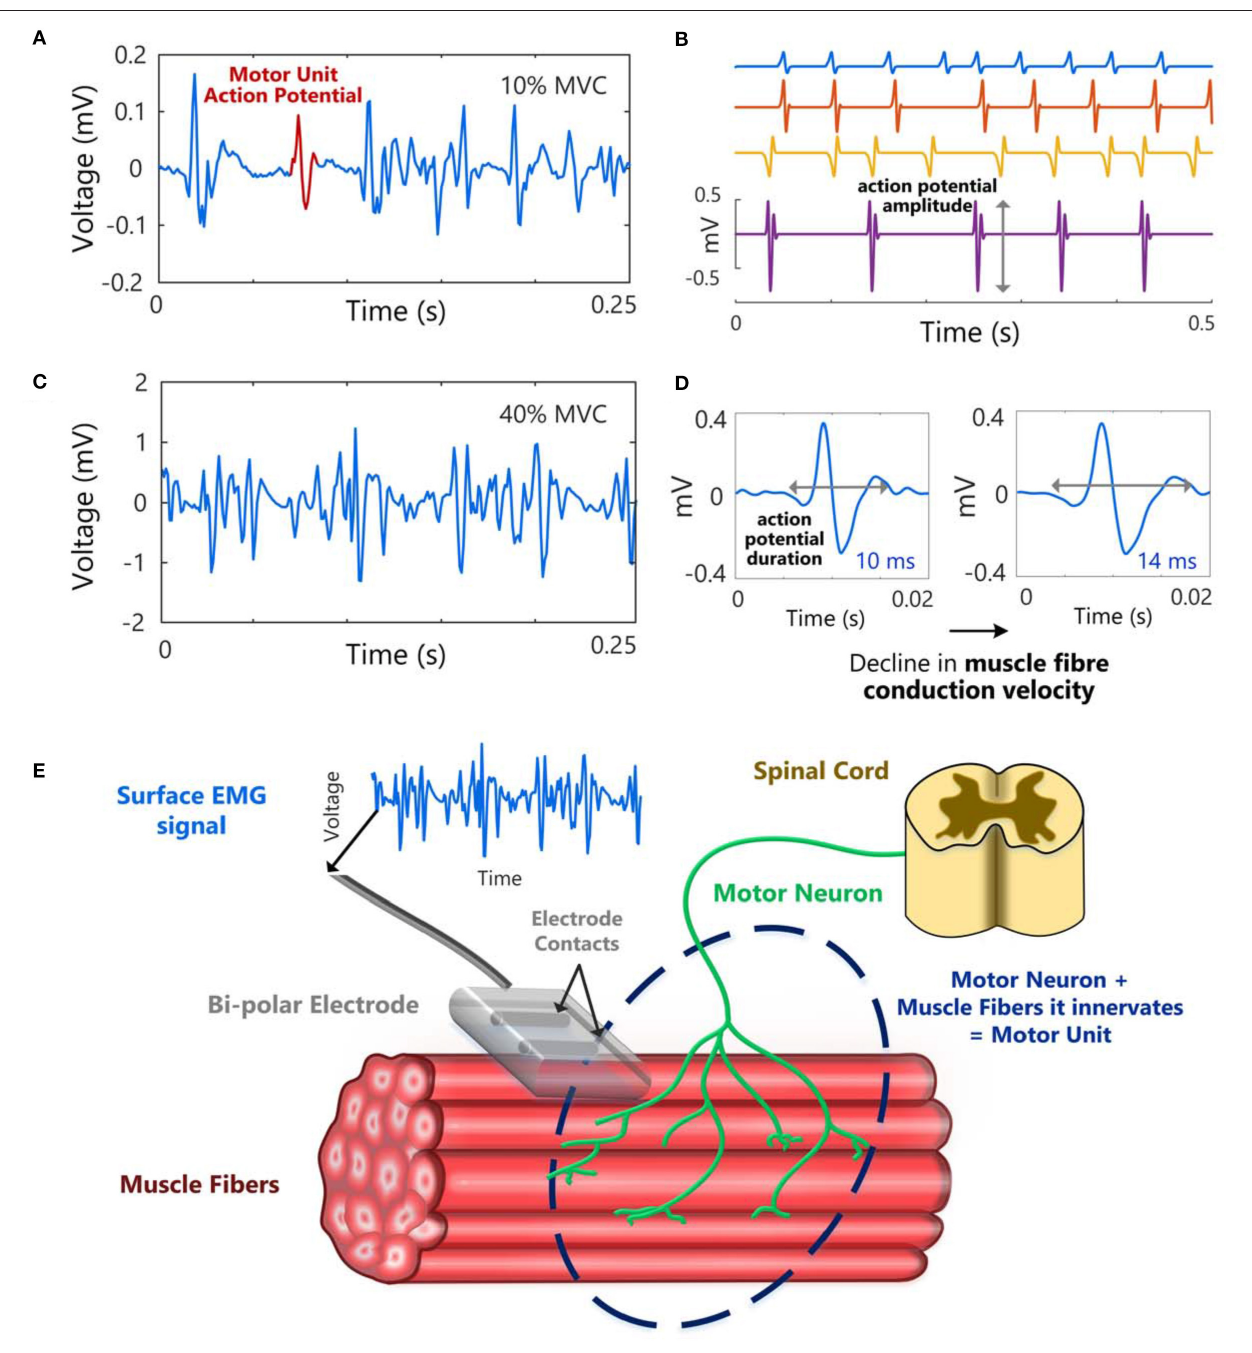
FIGURE 1 | Example of a surface EMG signal at a low force level (10% of maximum voluntary contraction, MVC) (A) and a higher force level, 40% MVC (C) , in the first dorsal interosseous muscle. (B) Single motor unit action potential trains with different inter-spike intervals (ISIs), i.e., different motor unit firing rates and (D) an illustration of the increase in action potential duration that can occur with a decline in muscle fiber conduction velocity. (E) A schematic to illustrate a motor unit, and how a surface EMG signal could be recorded from a muscle using a bipolar electrode (two electrode contacts).